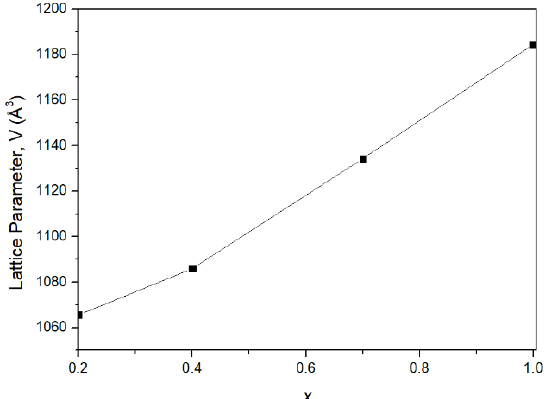
Figure 3. Orthorhombic unit-cell volumes at 250 ◦ C as a function of In 3+ content ( x ) in Al 2 − x In x W 3 O 12 . Standard deviations are smaller than symbol size. Table 1. Intrinsic and extrinsic CTEs by axis ( α a , α b , α c ) and average linear CTE ( α l ) in the Al 2−x In x W 3 O 12 system ( Pbcn space group for the orthorhombic phase and P2 1 /a for the monoclinic phase) with their standard deviations (standard deviations for x = 1 in monoclinic form are one order of magnitude higher than for others, since only three points were considered). Standard deviations for CTEs of the end-members are not reported in the literature [5,9]. Results not referenced to the literature are from the present study. RT refers to room temperature.